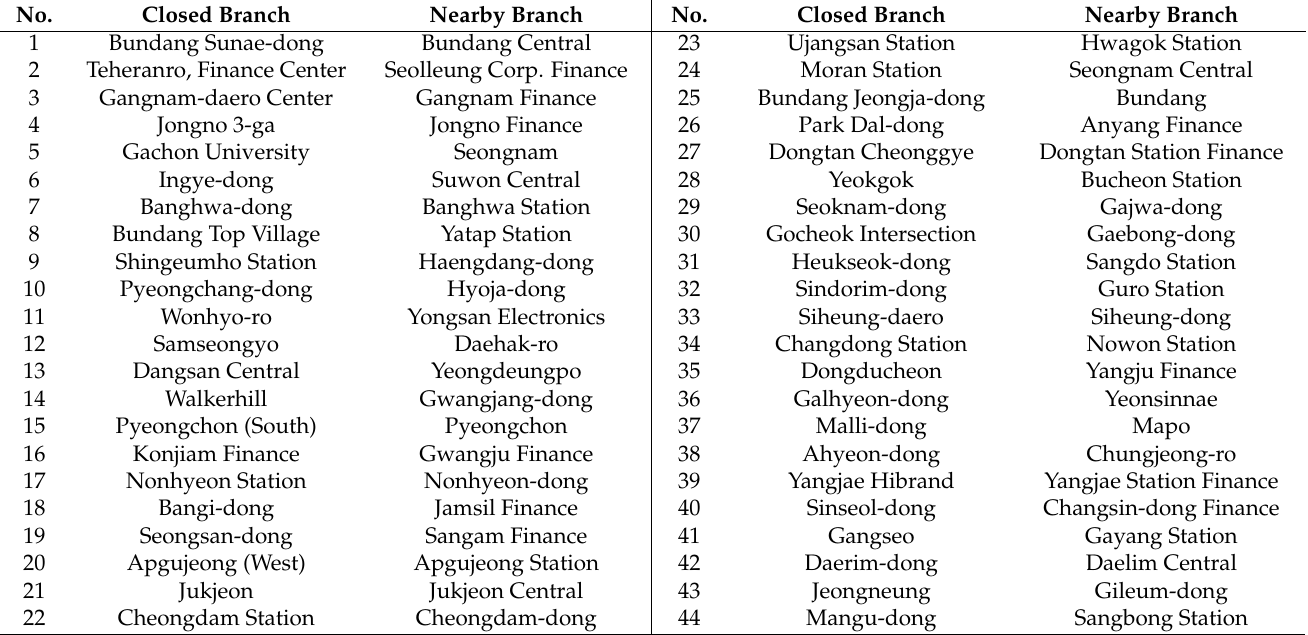
Table 5. The information about the bank branches.